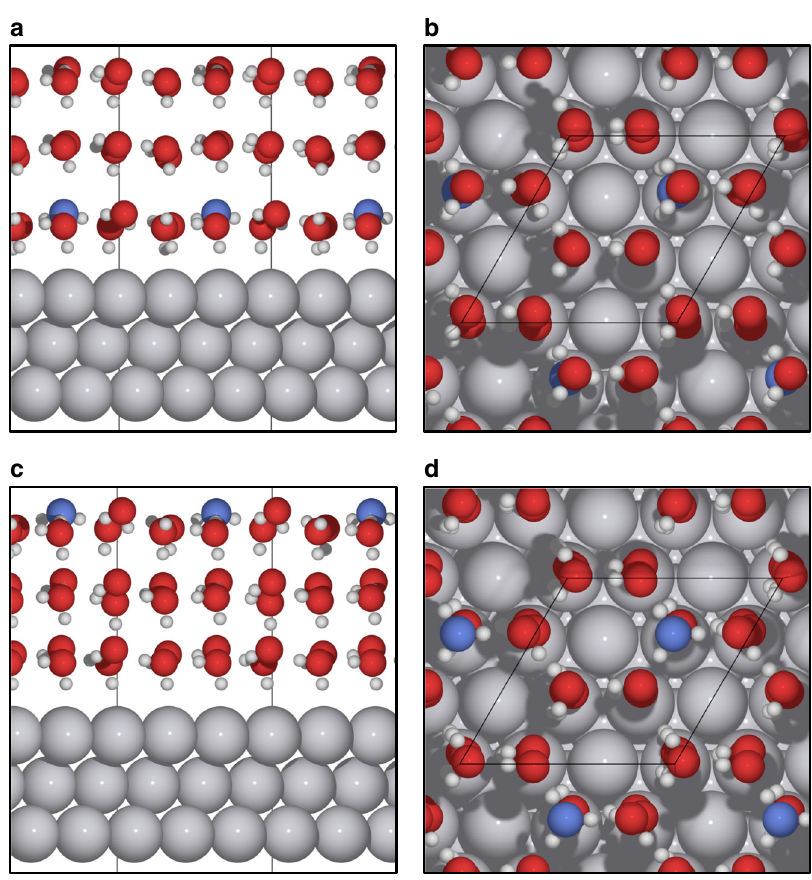
Fig. 1 Computational cells for the Pt(111) | acidi fi ed water interface. Gray spheres represent Pt atoms, red spheres represent O atoms, and white spheres represent H atoms. The hydronium oxygen is highlighted in blue in all cases. Periodic cells are separated by at least 15 Å of vacuum in the z direction between the metal and the solvent. a , b Side and top views of a proton in the outer Helmholtz plane, respectively. c , d Side and top views of a proton in the third solvent layer,